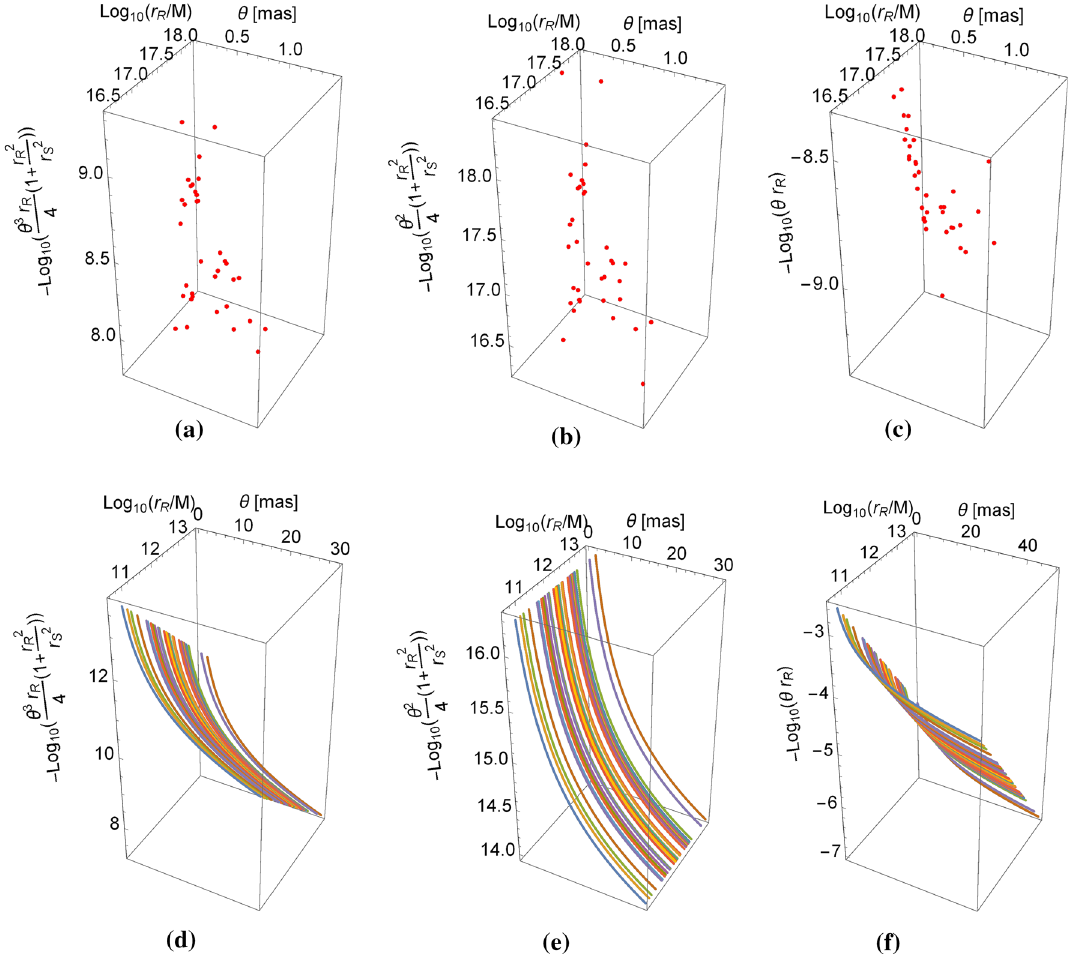
Fig. 3 Coefficients of a a / M in Eq. (51), b ( 1 − v) in Eq. (52) and c a / [ M ( 1 − v) ] in Eq. (53), for the microlensing case. The same coefficients for the BH lensing are in d – f . r R / r S = 1 was used. Data are from Ref.